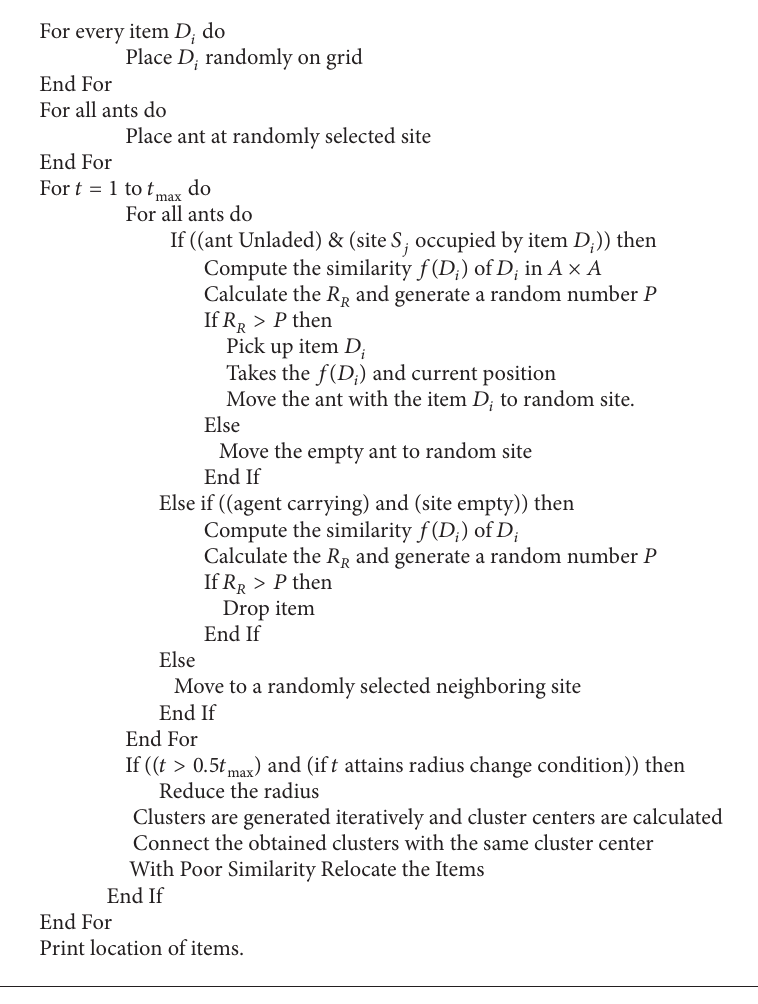
Algorithm 1: Ant colony optimization algorithm.